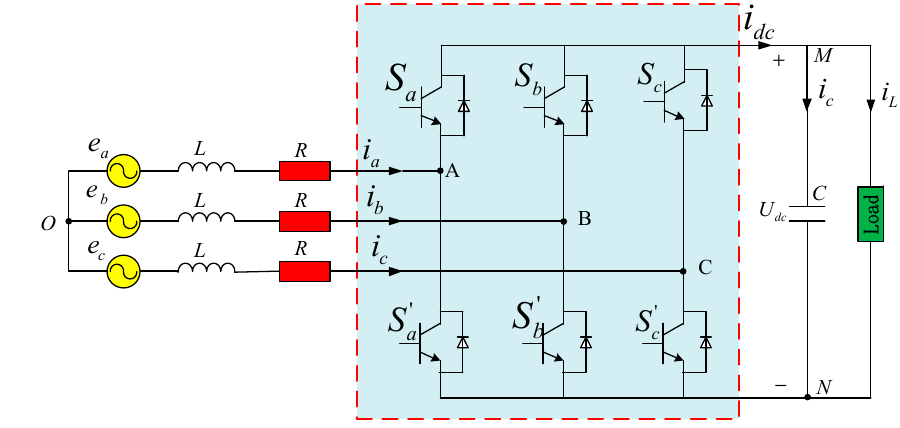
Figure 2. AC-DC converter circuit topology.